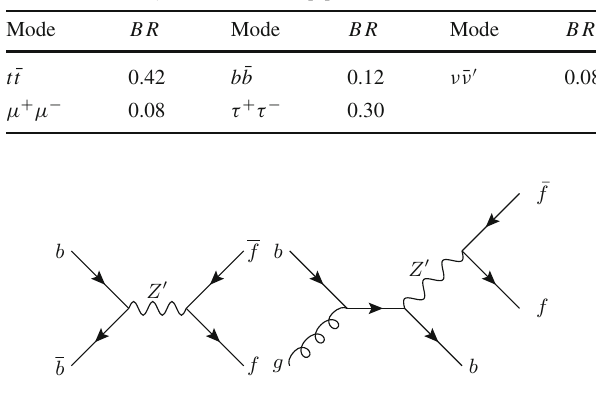
Fig. 4 LHC production of a Z (cid:2) , followed by its decay into a fermion anti-fermion pair f ¯ f . In the right-hand panel, we show the associated production with a b